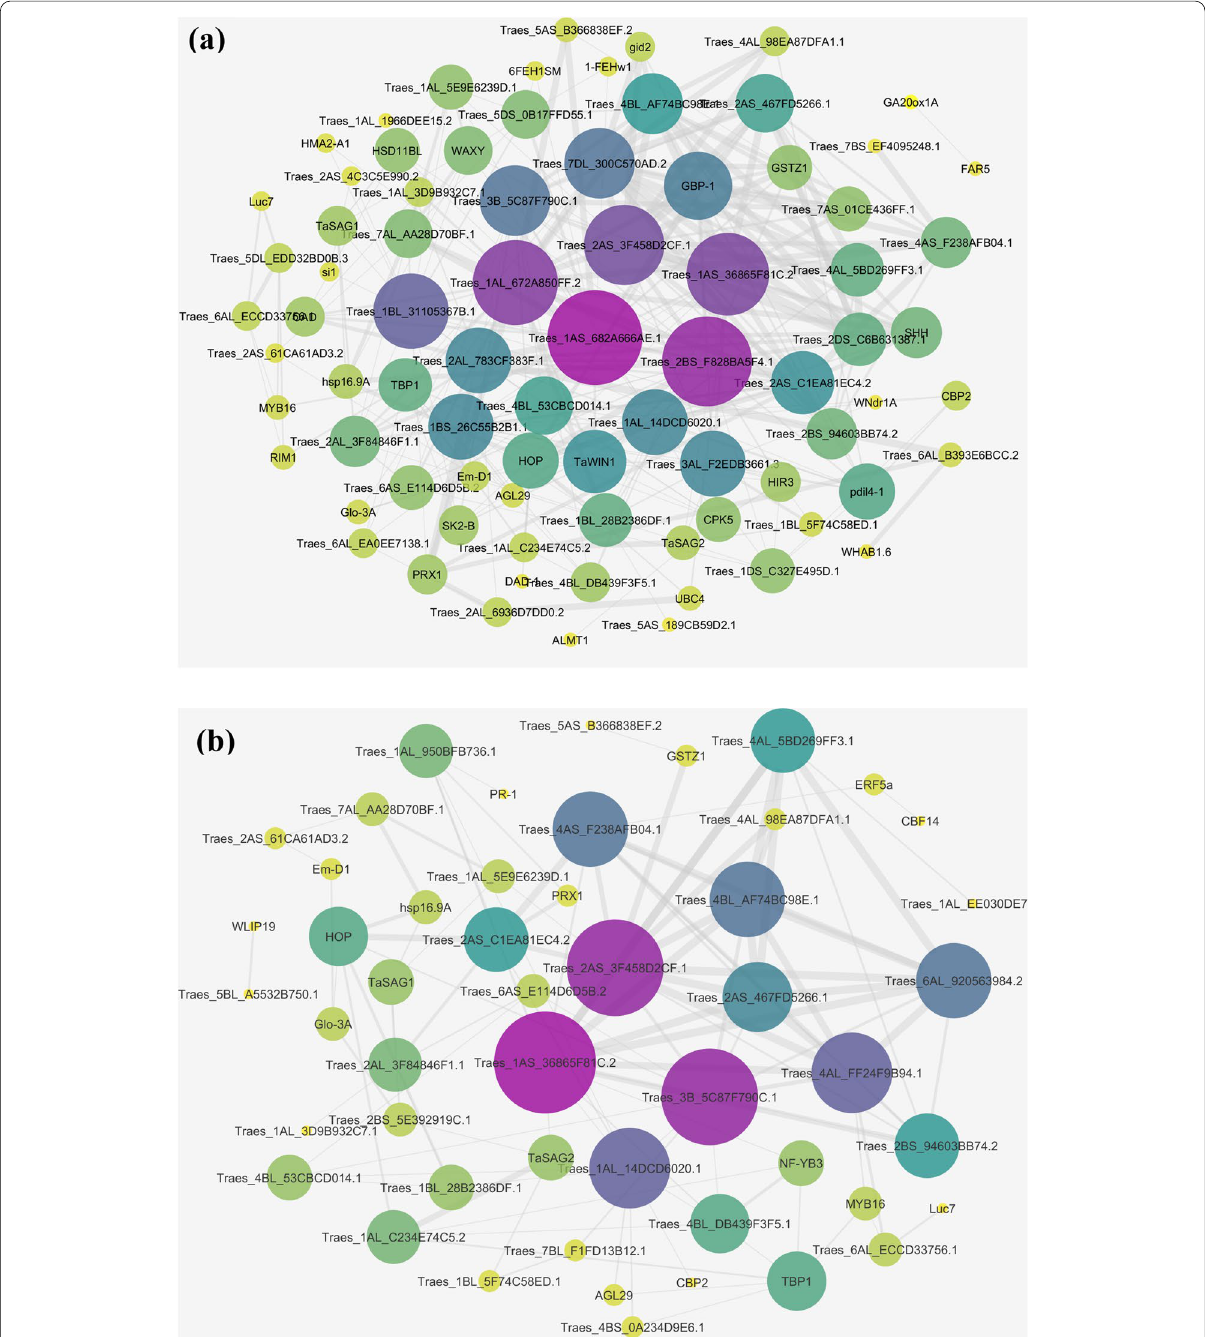
Fig. 4 Gene network for the wheat, sensitive cultivars ( a ) and tolerant cultivars ( b ). If the line is not connected to the protein, it does not indicate the association between that protein and other proteins. The number of lines further indicates that there is a large association between that protein and other existing